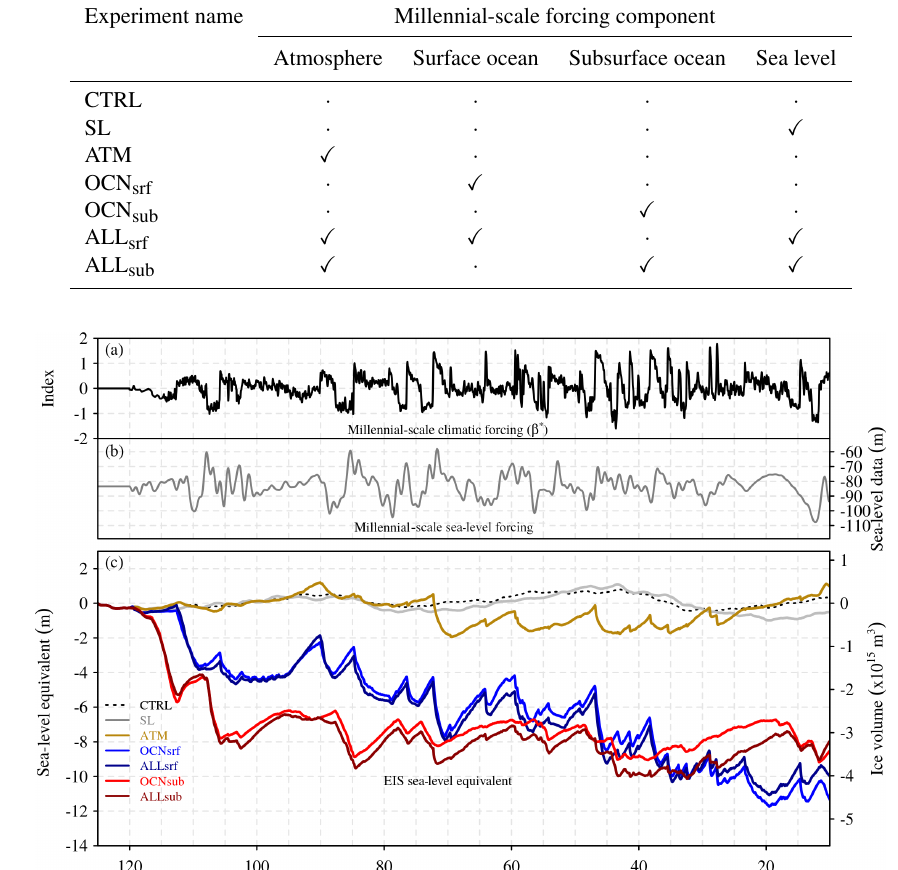
Table 2. Millennial-scale components used to force the ice-sheet model in the different experiments shown in this study.